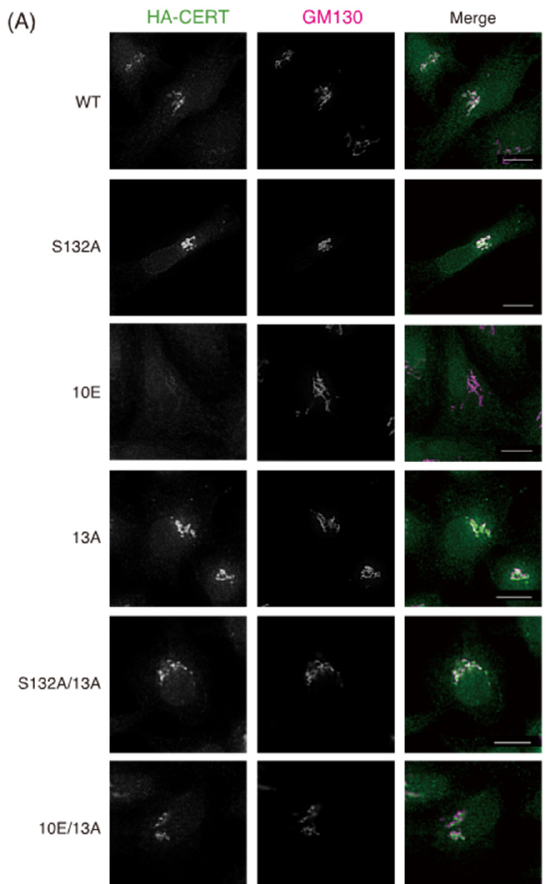
Figure 3. The 13A mutation enhances localization of CERT 10E to the Golgi apparatus. ( A ) HeLa CERT KO/shCERT cells expressing HA-CERT WT, S132A, 10E, 13A, S132A/13A, or 10E/13A were co-immunostained with an anti-HA rat monoclonal antibody and an anti-GM130 mouse monoclonal antibody. All scale bars represent 10 μ m. ( B ) The Golgi-localization degree of each CERT mutant was determined as described in the Materials and Methods section. Results are shown in SuperPlots [25]. The small symbols indicate the analyzed values of all cells in each experiment, and the large symbols indicate the means of the values in each experiment. Results of three experiments are shown in orange circles, blue squares, and gray triangles, respectively. Significance was determined using the paired t-test adjusted by the Benjamini–Hochberg method [26] for multiple comparisons; p -values < 0.05 were considered statistically significant.